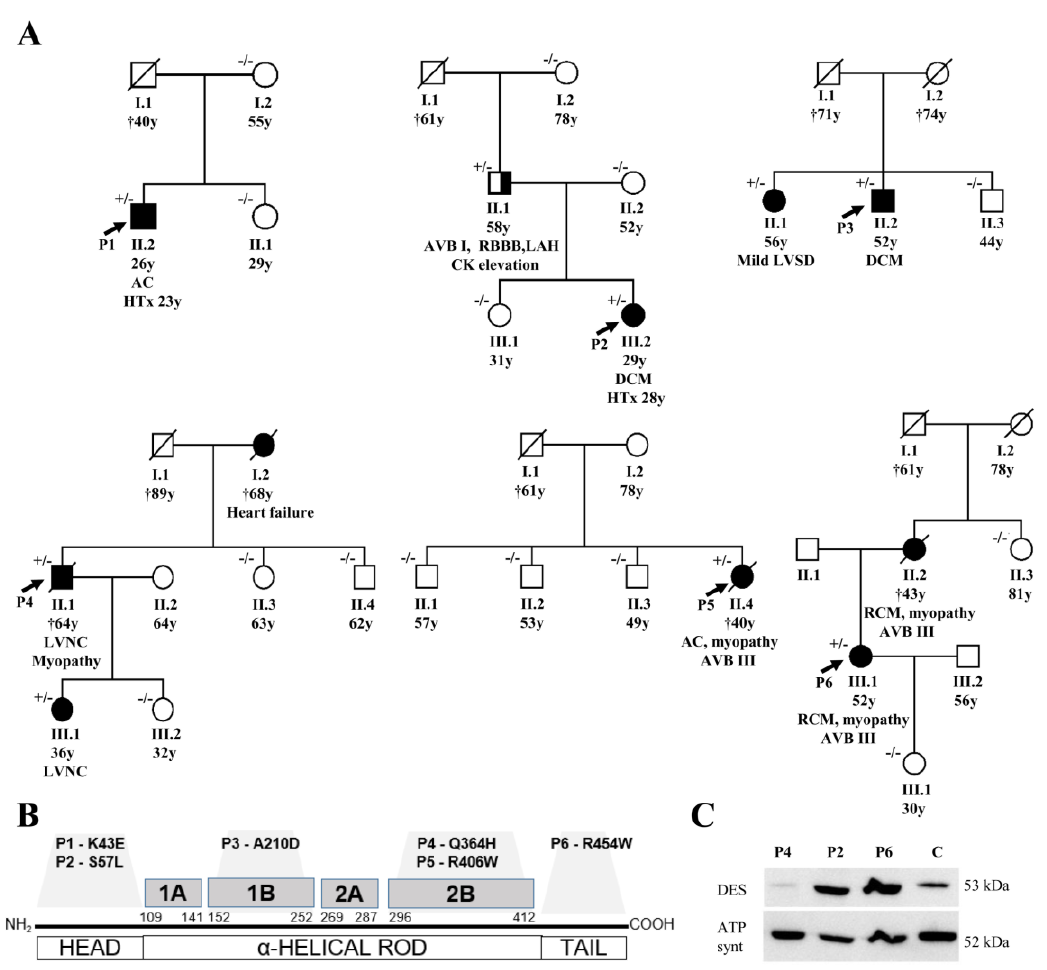
Figure 1. ( A ) shows pedigrees of the affected families and segregation of desmin variants (+/ − heterozygous status, − / − wild type). In the fourth family (with P4) we also assessed a segregation of the rare variant of MYH7 (NM_000257.3), c.4679G > C, p.(Arg1560Pro), which was present just in P4 (II/1) and absent in II/3, II/4, III/1, and III/2. ( B ) summarizes the structure of the desmin gene with localization of the detected variants. ( C ) illustrates the detection of desmin by western blot in myocardial samples (P2, P4, P6, control sample; 30ug protein aliquots) with an obvious reduction of signal in P4 with left ventricular non-compaction cardiomyopathy ( DES -p.(Q364H)). Abbreviations: AC = arrhythmogenic cardiomyopathy, AVB = atrioventricular block, DCM = dilated cardiomyopathy, DES = desmin, HTx = heart transplantation, LAH = left anterior hemiblock, LVNC = left ventricular non-compaction cardiomyopathy, LVSD = left ventricular systolic dysfunction, RBBB = right bundle branch block, and RCM = restrictive